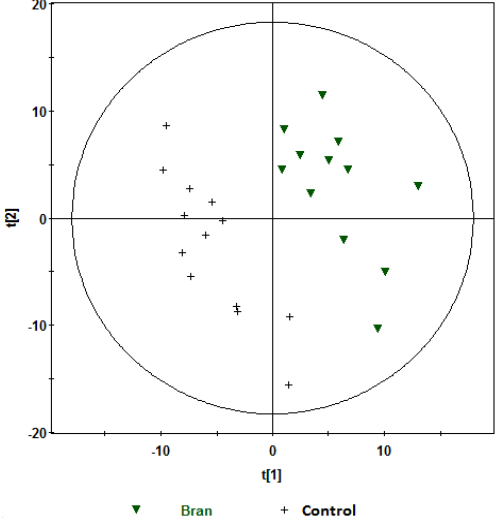
Figure 6. PLS-DA scores plot (t[1]) vs. t[2]) obtained from 1 H NMR spectra of postprandial urine